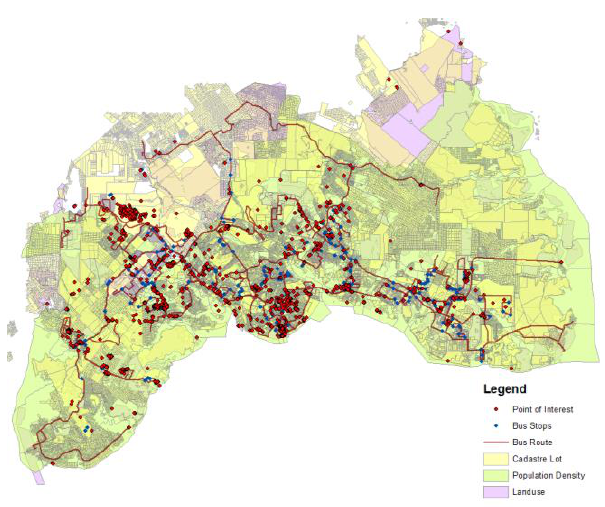
Figure 2 Collected data within study